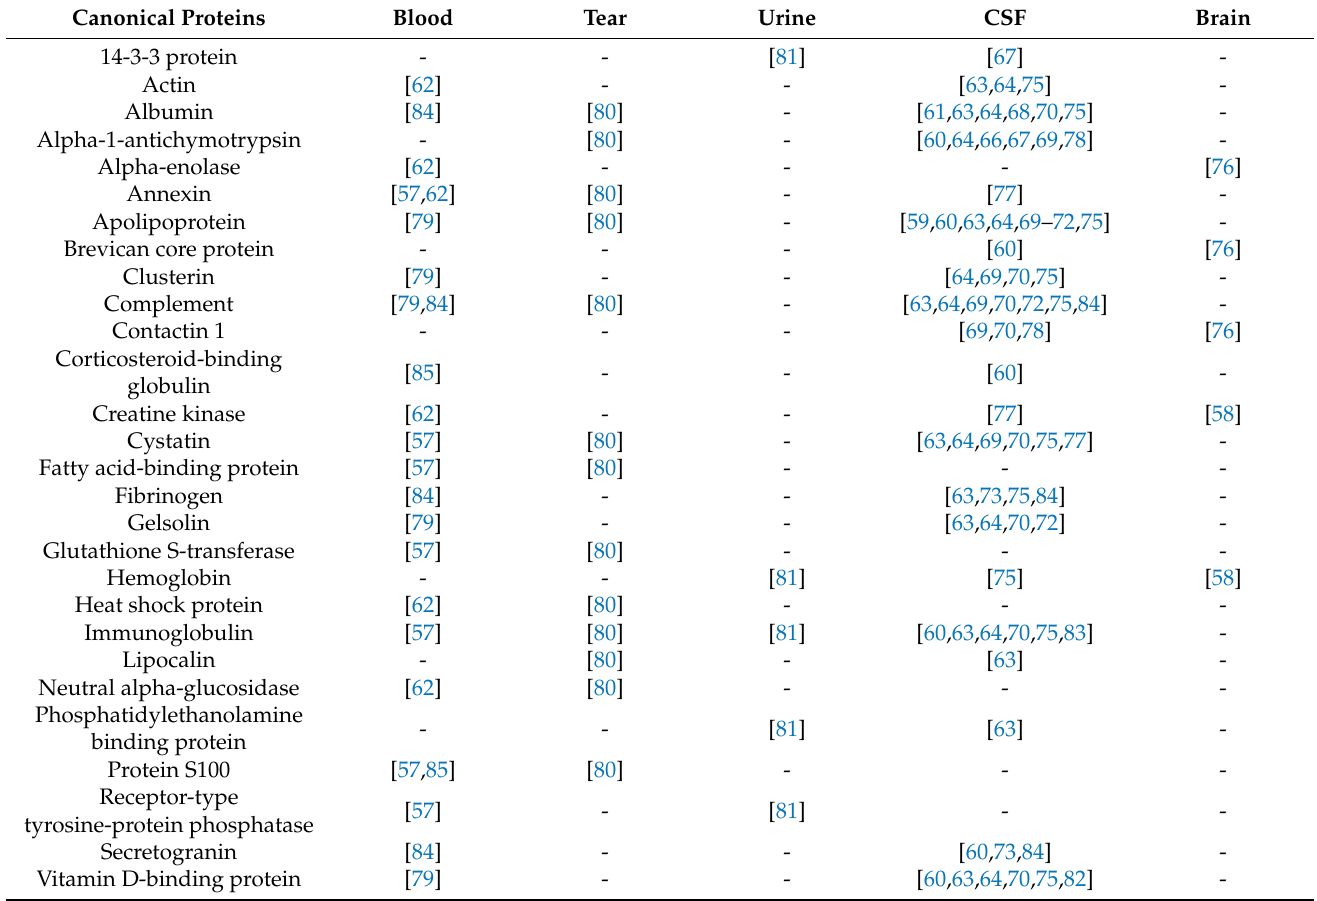
Table 2. Canonical proteins identified in different sample types from MS